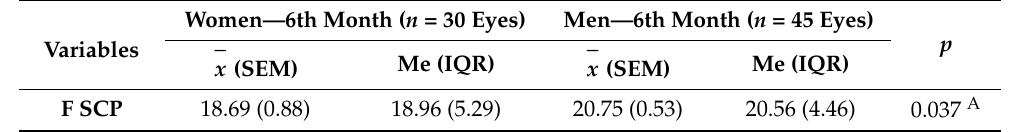
Table 5. Comparison of foveal (F) and parafoveal parameters of OCTA (optical coherence to- mography angiography) parameters between women and men in the 6th month in COVID-19 patients: SCP—superficial capillary plexus, DCP—deep capillary plexus, CC—choriocapillaris, FAZ s—superficial foveal avascular zone, FAZ d—deep foveal avascular zone, F—foveal area,